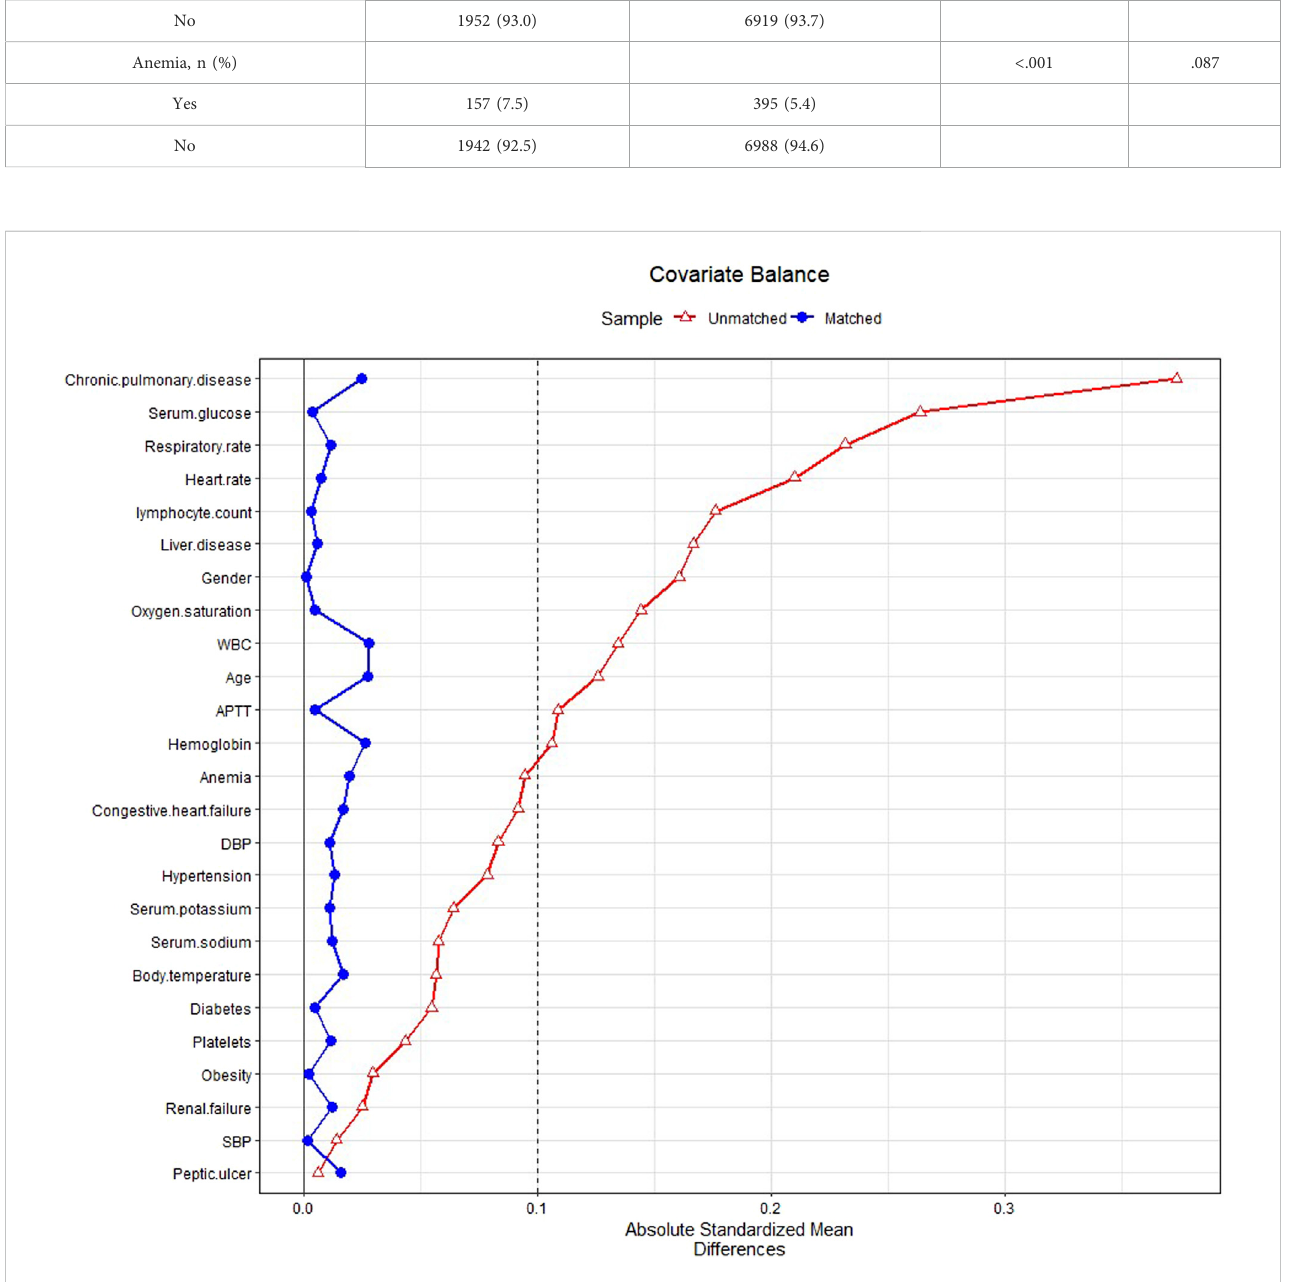
glucocorticoid and non-glucocorticoid groups were 71.28 and 73.01 years, respectively. The numbers of males and females were 979 and 1,120 in the glucocorticoid group, respectively, and 4,035 and 3,348 in the non-glucocorticoid group. The numbers of patients with congestive HF in the